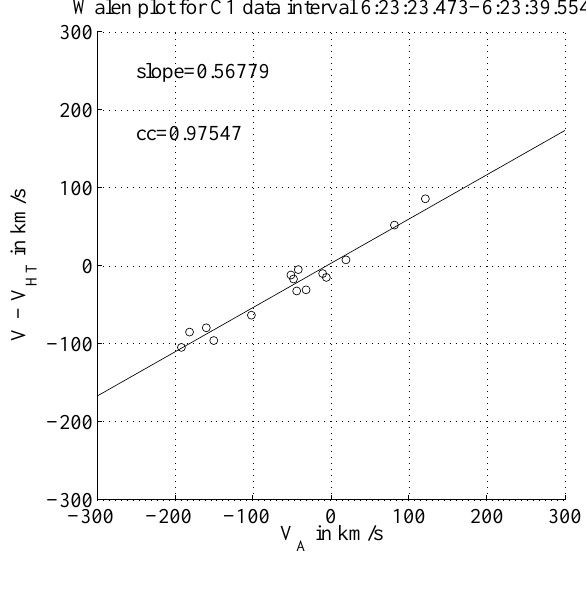
Fig. 10. Wal´en relation across the magnetopause encountered by C1 at 06:23 UT on 5 July 2001. V HT =( − 242.65, − 84.71, 162.28)km/s in GSE.